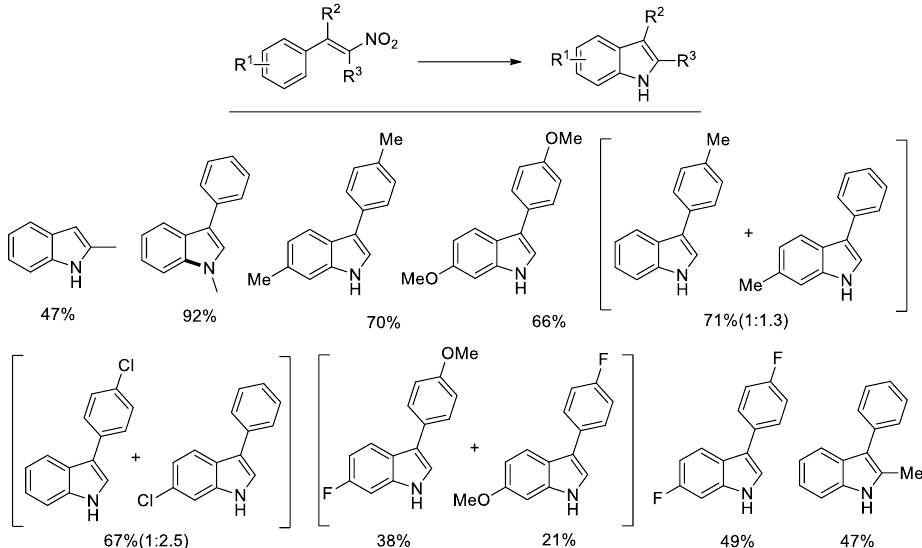
Figure 2. Synthesis of indoles from β -nitrostyrenes. Experimental conditions: 0.54 mmol nitrostyrene, 1 mol% PdCl 2 (CH 3 CN) 2 , 5 mol% Phen, 260 μL PhOC(O)H, 120 μL Et 3 N, in CH 3 CN (10 mL) at 140 °C for 4 h.